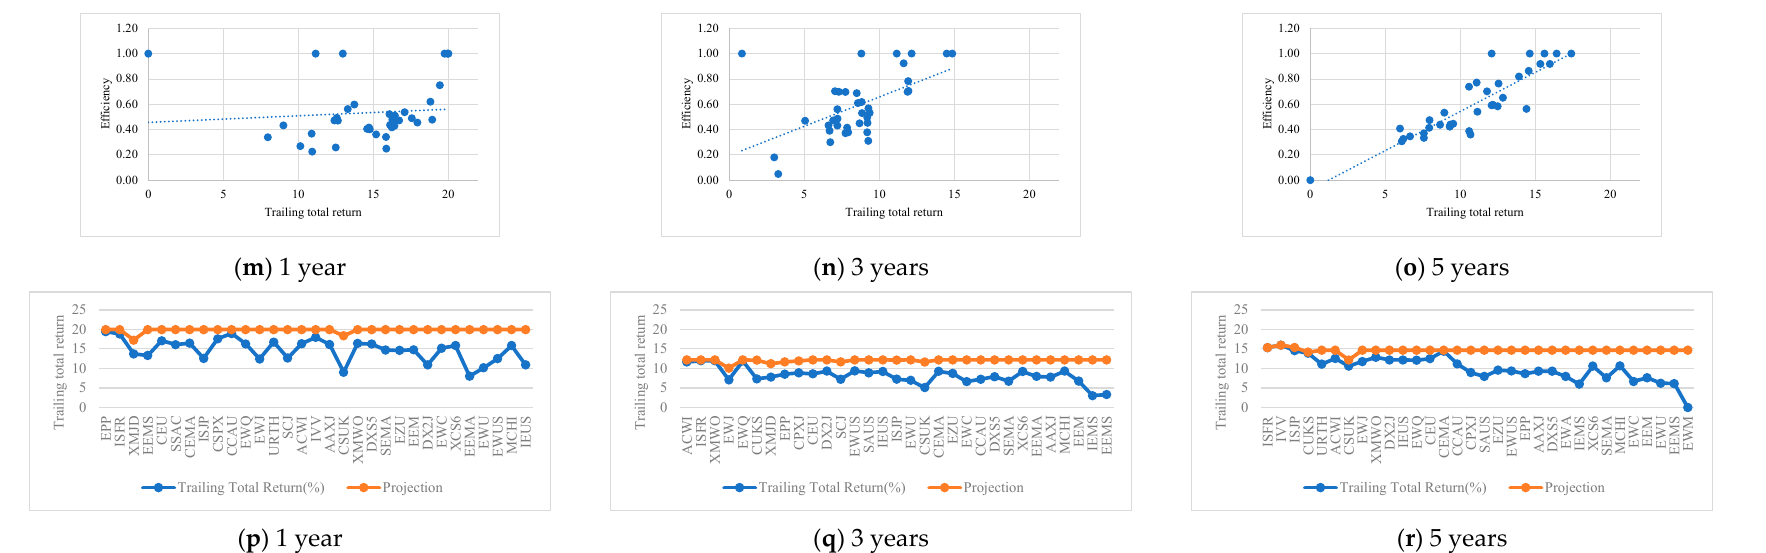
Figure 8. Efficiency scores vs. outputs and projections (ETFs are ordered in decreasing order of efficiency) for the different time horizons–M4.